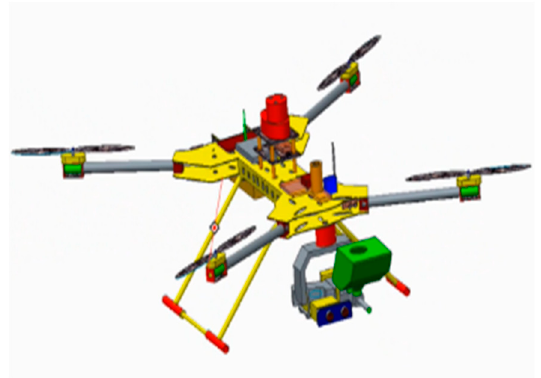
Figure 1. 3D modeling.